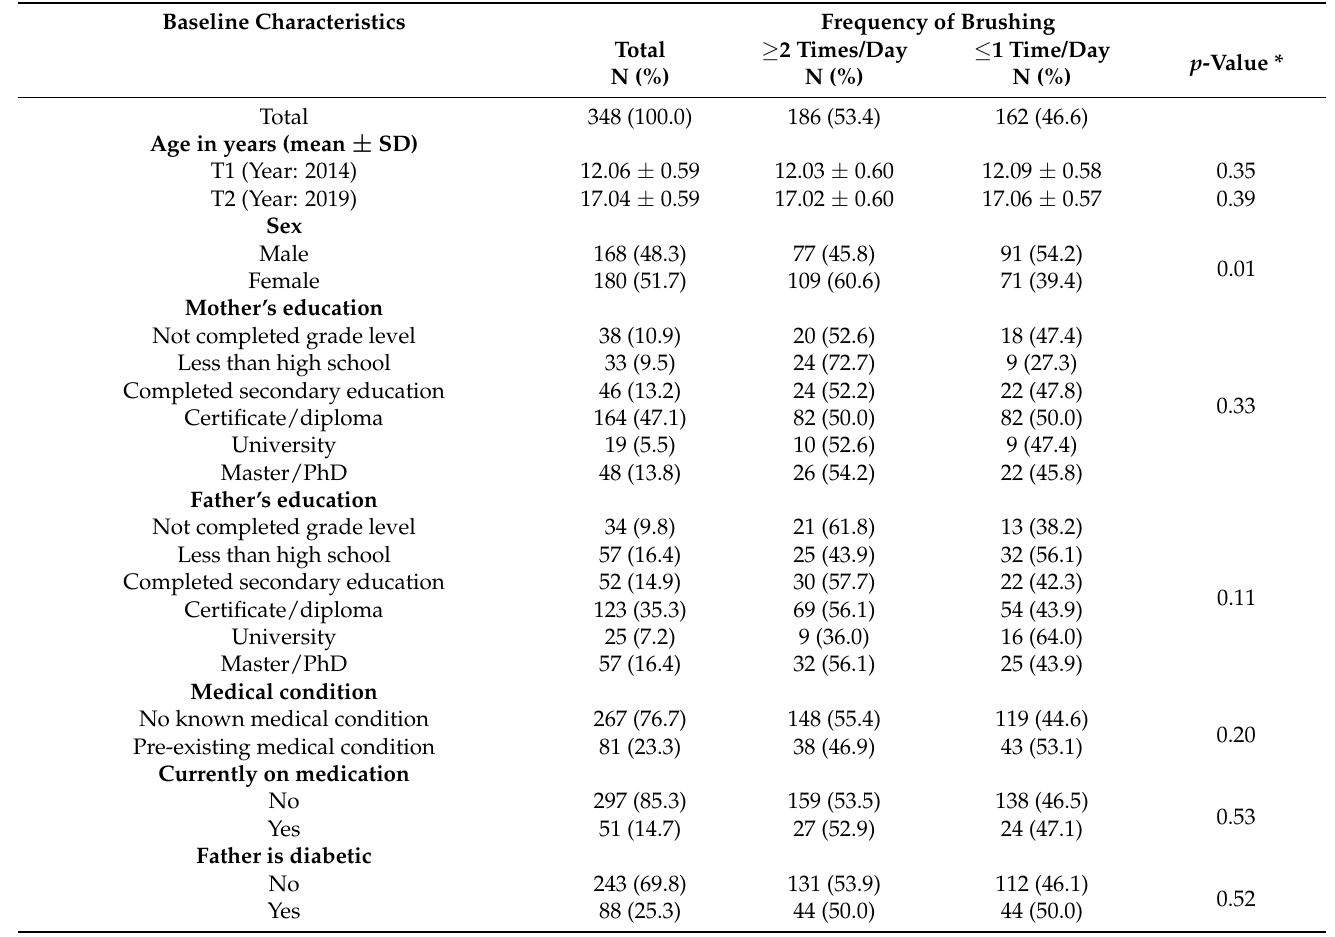
Table 1. Baseline characteristics of the participants in relation to frequency of